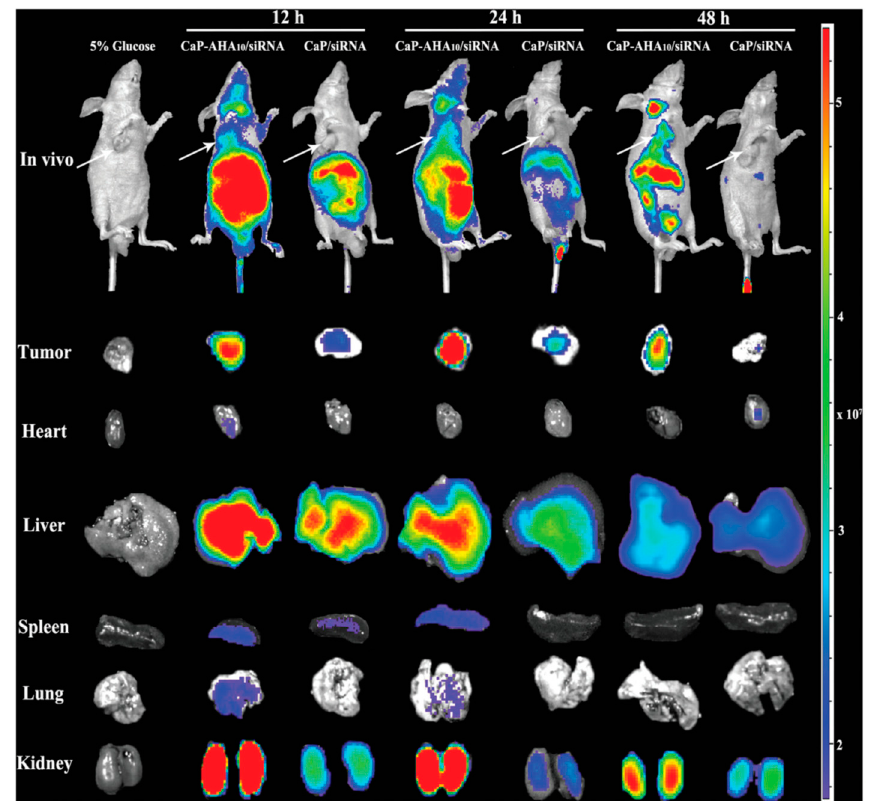
Figure 9. In vivo distribution of calcium phosphate particles loaded with siRNA observed by the in vivo imaging system. The nude mice bearing the A549 tumor was given intravenous injection via tail vein. Reproduced with permission from [189]. Royal Society of Chemistry,